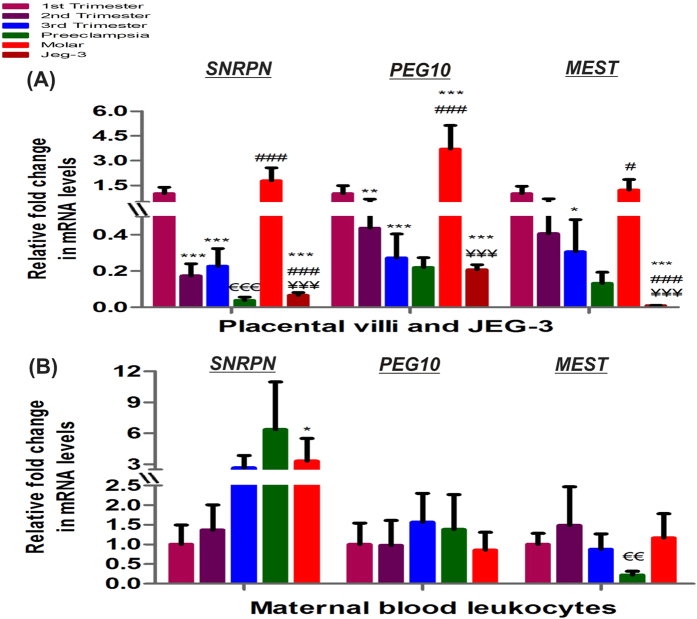
Relative fold change in mRNA of imprinting genes normalized with GAPDH.Relative mRNA expression among (A) placental villous samples and JEG-3 cells (B) maternal blood leukocytes [*p < 0.05, **p < 0.01, ***p < 0.001 vs 1st trimester, #p < 0.05, ###p < 0.001 vs 2nd trimester, €€p < 0.01, €€€p < 0.001 vs 3rd trimester and ¥¥¥p < 0.001 vs molar]. The data is presented as mean of the observed fold change ± SEM, n = 30 per group.